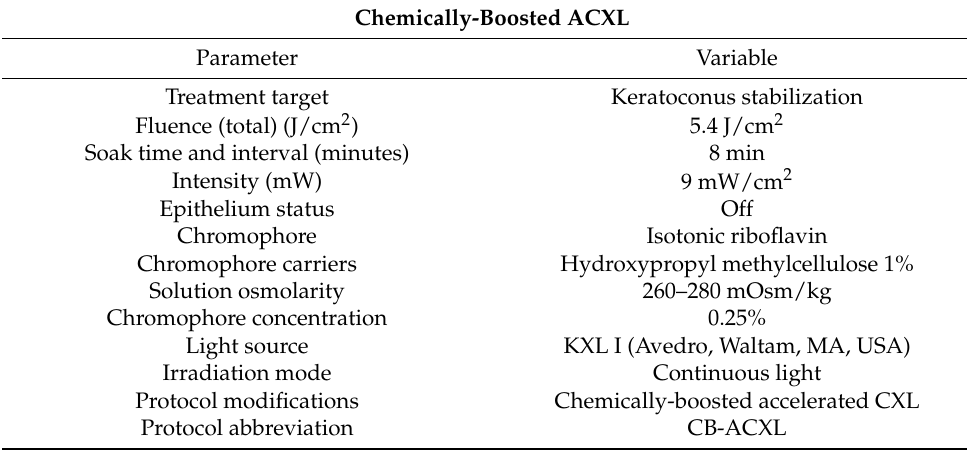
Table 2. Chemically-boosted ACXL (CB-ACXL) using SafeCross ® solution.